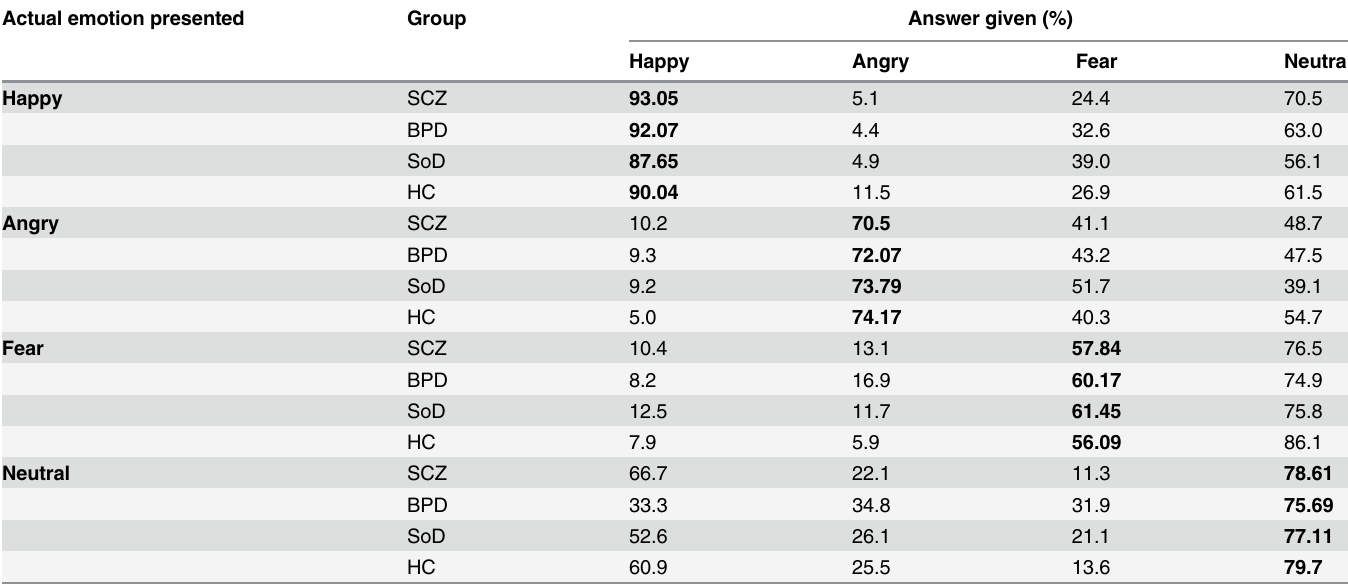
Table 2. Values represent percent misattribution errors for each of the four facial expressions in the degraded facial affect labeling task separated by group, e.g. 5.1% of happy misattributions were due to ‘ Happy expressions being mistaken for Angry ’ in schizophrenia patients. Bold values (along the diagonal) represent percent correct for each facial expression by